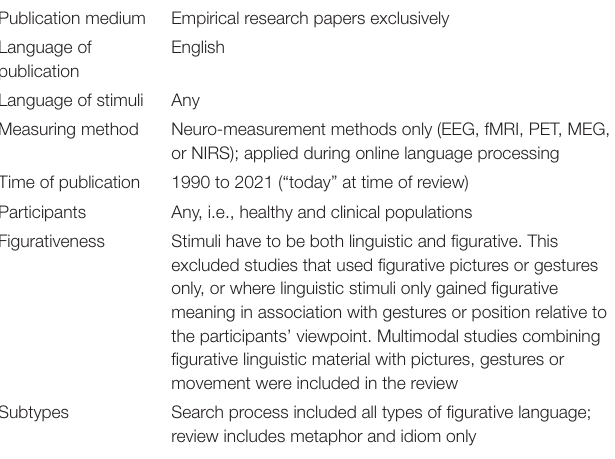
TABLE 1 | Inclusion criteria for our